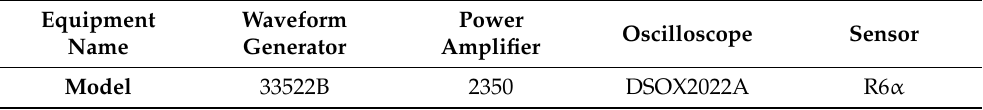
Table 2. Equipment information for ultrasound